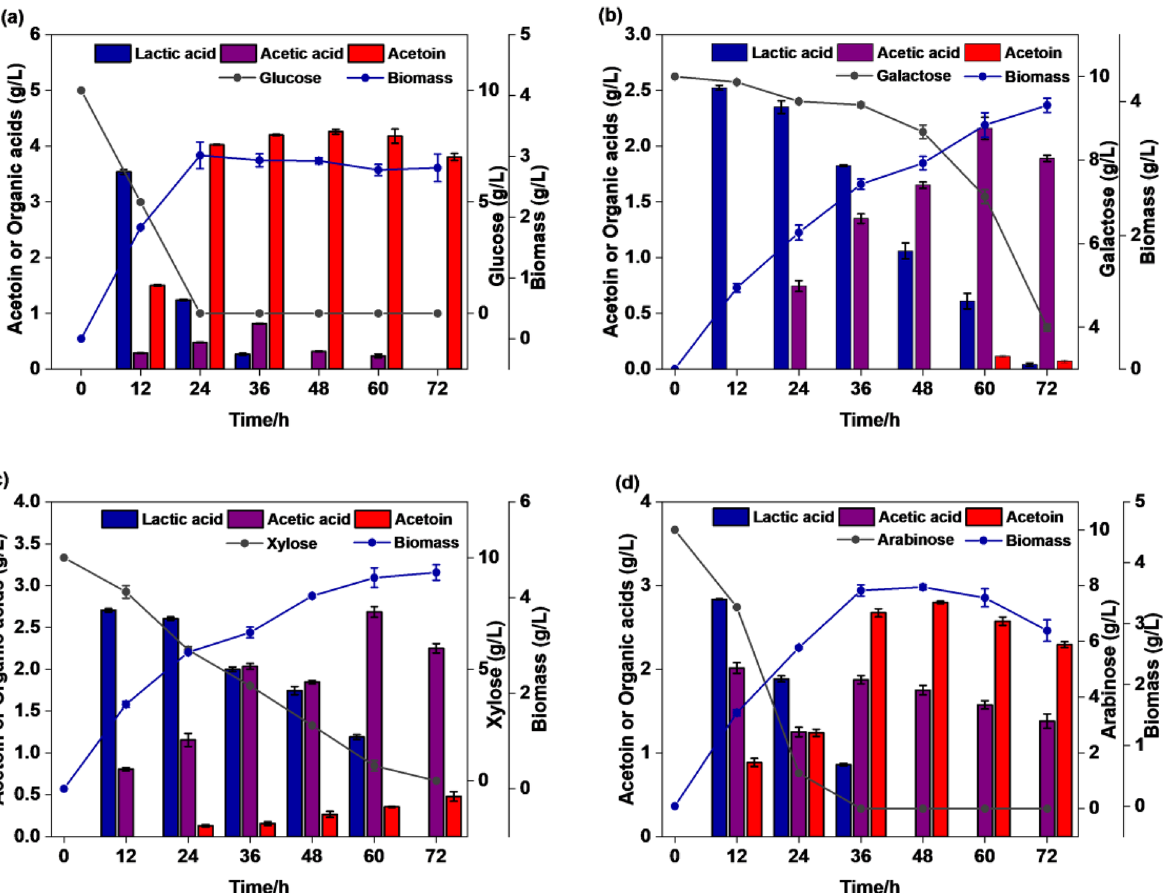
Fig. 5 The recombinant BS03 strain was fermented with different monosaccharides to produce acetoin under micro-aerobic conditions. a Glucose; b Galactose; c Xylose; and d Arabinose